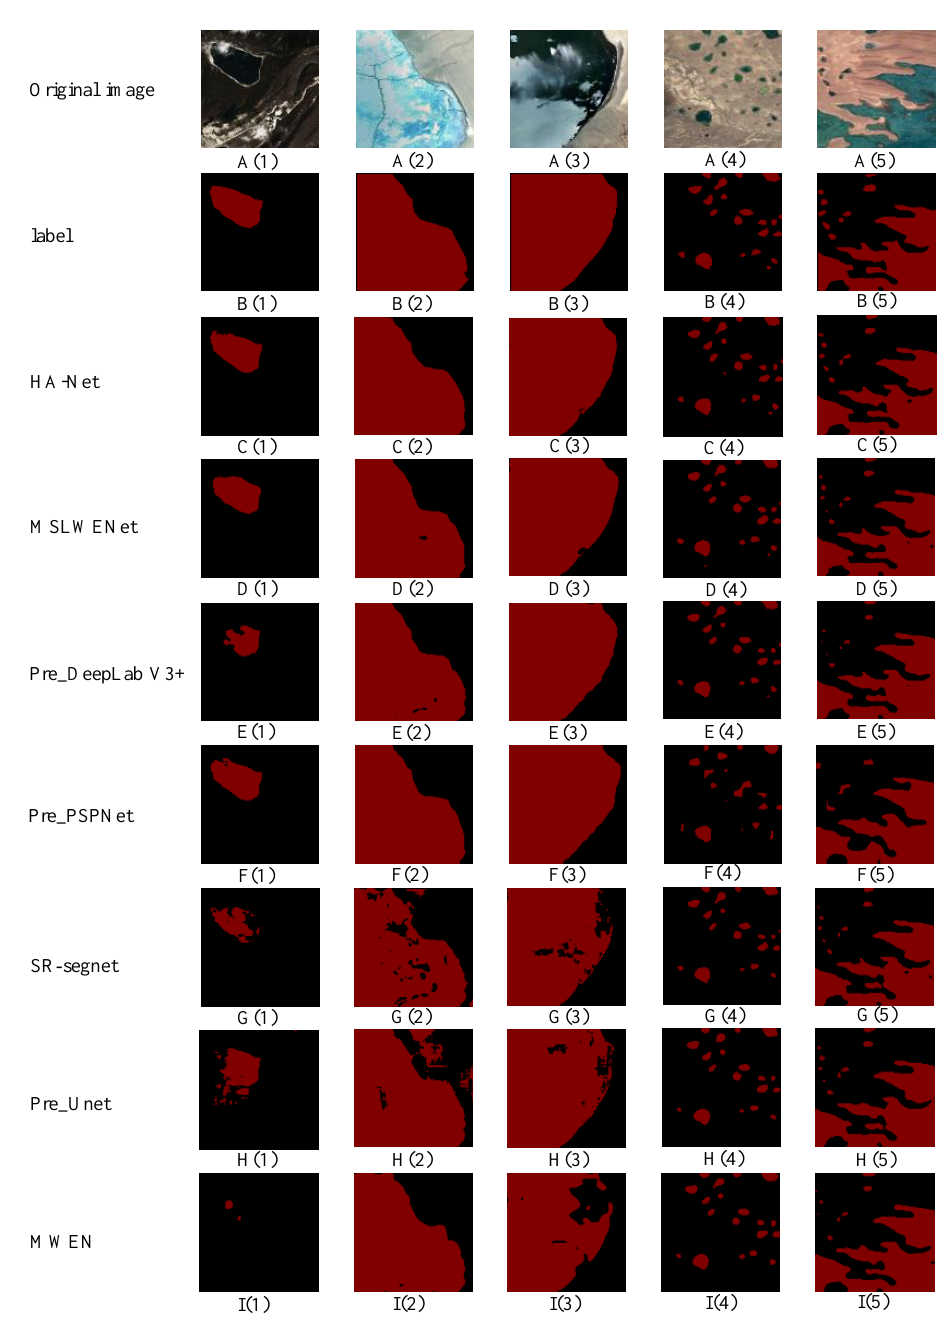
Figure 9. The visualization results of comparing the proposed method against other methods in small lake and noisy regions. ( A ( 1 )– A ( 5 )) are the raw images in the Google test set; ( B ( 1 )– B ( 5 )) are the ground truths to which the raw images correspond; ( C ( 1 )– C ( 5 )), ( D ( 1 )– D ( 5 )), ( E ( 1 )– E ( 5 )), ( F ( 1 )– F ( 5 )), ( G ( 1 )– G ( 5 )), ( H ( 1 )– H ( 5 )), and ( I ( 1 )– I ( 5 )) are the extracted results of HA-Net, MSLWENet, Pre_DeepLab V3+, Pre_PSPNet, SR-segnet, Pre_Unet, and MWEN,